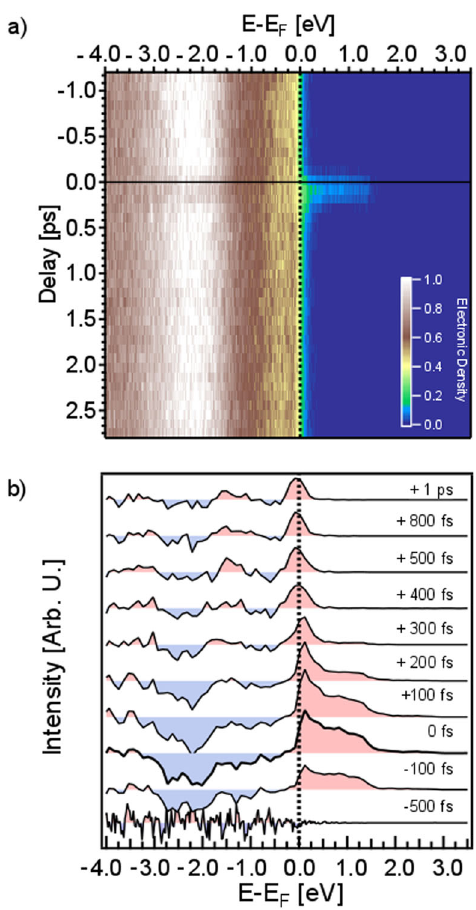
Fig. 2 Time-resolved x-ray photoelectron spectroscopy of FeRh. a Energy- and delay-dependent matrix of the measured spectra. The vertical dashed line marks the position of the Fermi level E F , while the horizontal solid line designates the time zero, t 0 . The appearance of electronic density in the unoccupied states is a fi ngerprint of the laser excitation. We used this spectral feature to identify the temporal overlap between the optical pump and the x-ray probe pulses. b Differential photoelectron spectra at selected delays. To enhance the signal to noise ratio, we average the unpumped spectra (between − 1 ps and − 0.5 ps) and subtract the average spectrum from each row of the matrix. This allows evaluating the statistical noise at negative time delays ( − 500 fs) as well as accentuating the temporal evolution of the photoelectron spectra. Red and blue shaded areas indicate an increase and a reduction of the electron density with respect to the spectra at negative delays,